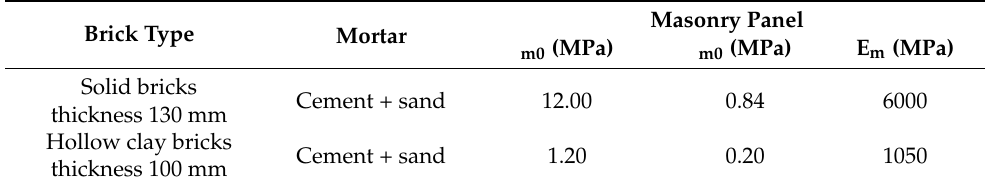
Table 8. Mechanical characteristics of the constitutive materials composing the masonry infill